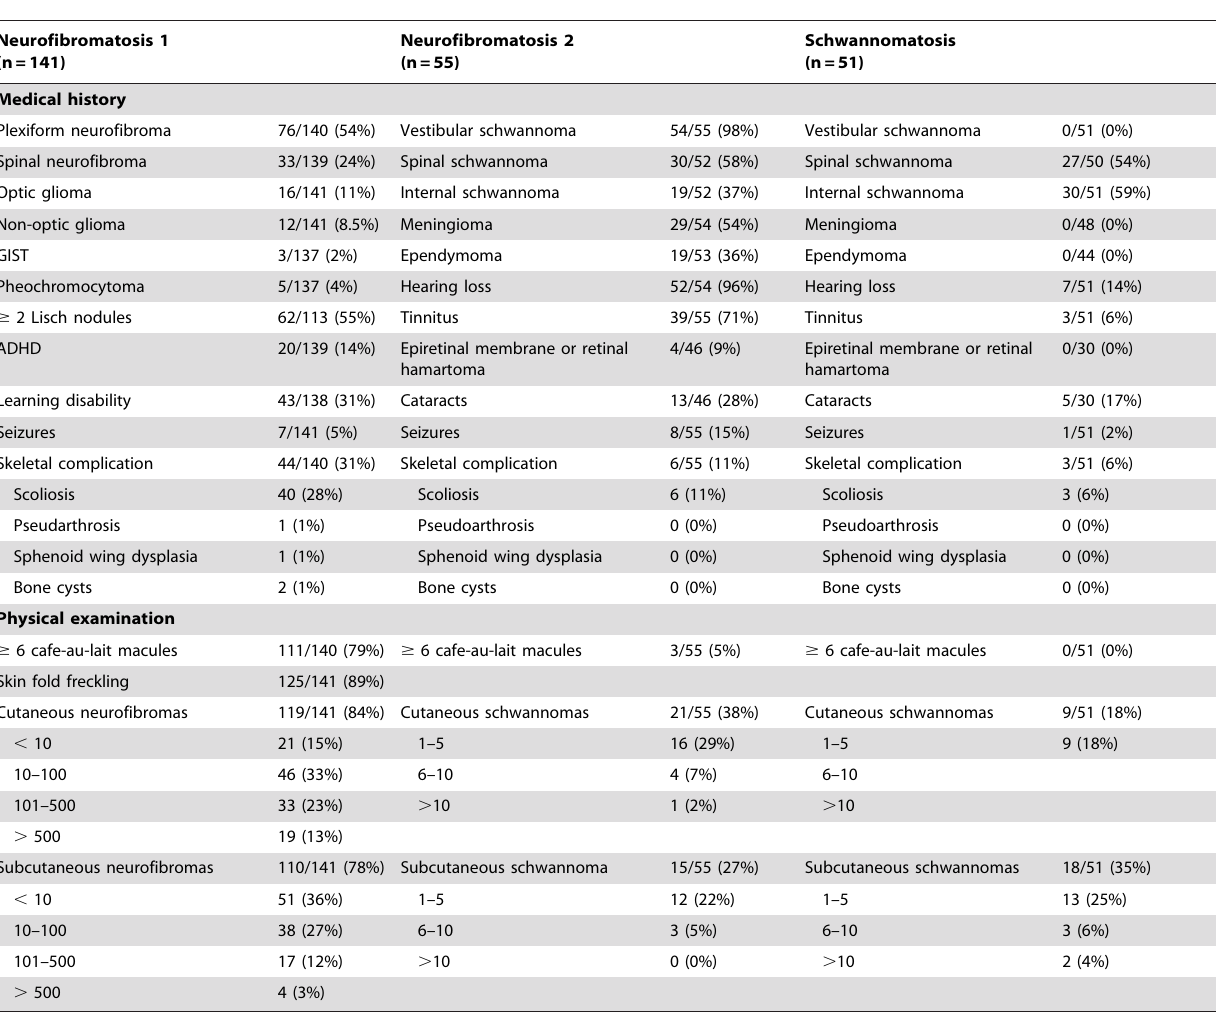
Table 2 . Clinical features of the 247 patients who underwent whole-body